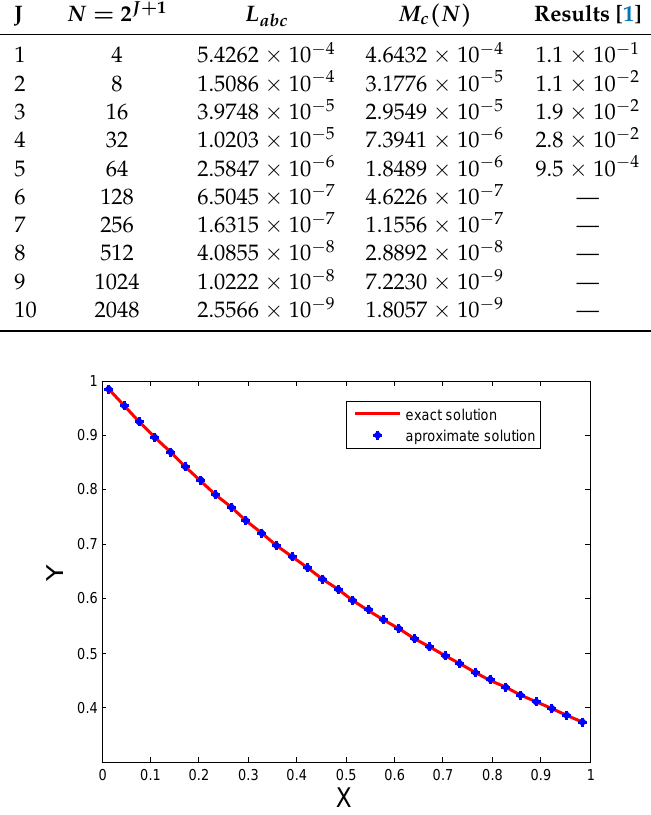
Figure 2. Comparison of both solutions for N = 32 for Test Problem